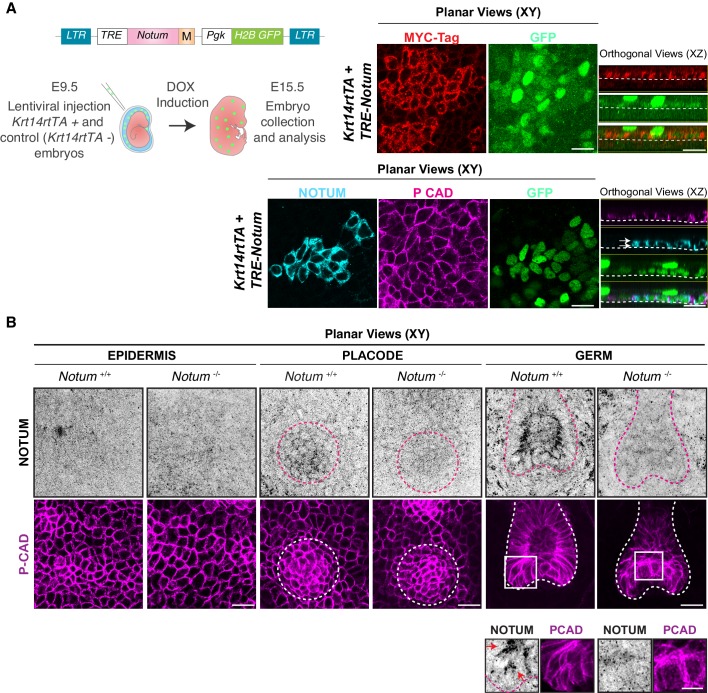
NOTUM expression during early hair follicle development.(A) Strategy to monitor NOTUM by MYC-epitope tagging (M). Depicted LV was introduced into the amniotic cavities of E9.5 Krt14rtTA embryos and the transduced Notum gene was activated by doxycycline (DOX). Representative whole-mount planar (XY) and orthogonal (XZ) views of NOTUM-MYC-tag immunostaining. Note that within the plane of embryonic epidermis, NOTUM is uniformly distributed (white arrows). Dashed lines demarcate the border between epidermis and dermis. (B) Endogenous NOTUM immunolocalization in wild-type and Notum-null skin, is shown by whole-mount immunofluorescence of interfollicular epidermis, hair placode and hair germs. P-Cadherin co-immunolabeling was used to mark the skin epithelium. Dotted circles/lines encase the developing hair follicles. Boxed areas are magnified in the boxes below the relevant images. Note little or no NOTUM in interfollicular epidermis. However, NOTUM is expressed in developing hair placodes. At the hair germ stage, it is clear that endogenous NOTUM protein concentrates on the apical side of WNThi epithelial cells (insets, red arrows). Notum-null skin was used as a control to show the specificity of the NOTUM antibody. All scale bars, 20 μm.